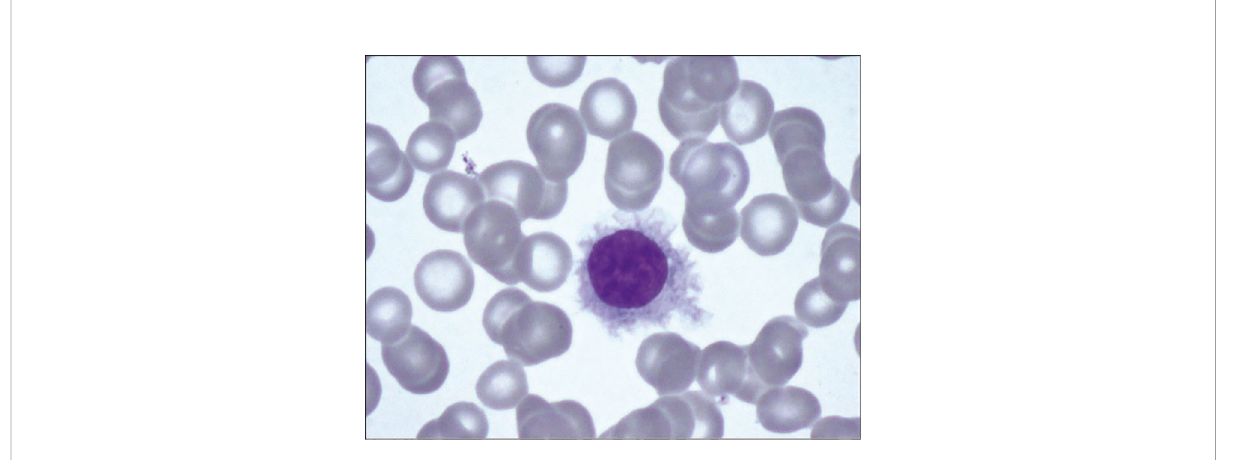
FIGURE 1 Peripheral blood smear with Wright-Giemsa staining showing hairy cell with abundant pale blue cytoplasm, slightly irregular nucleus with ground glass chromatin and hairy cell